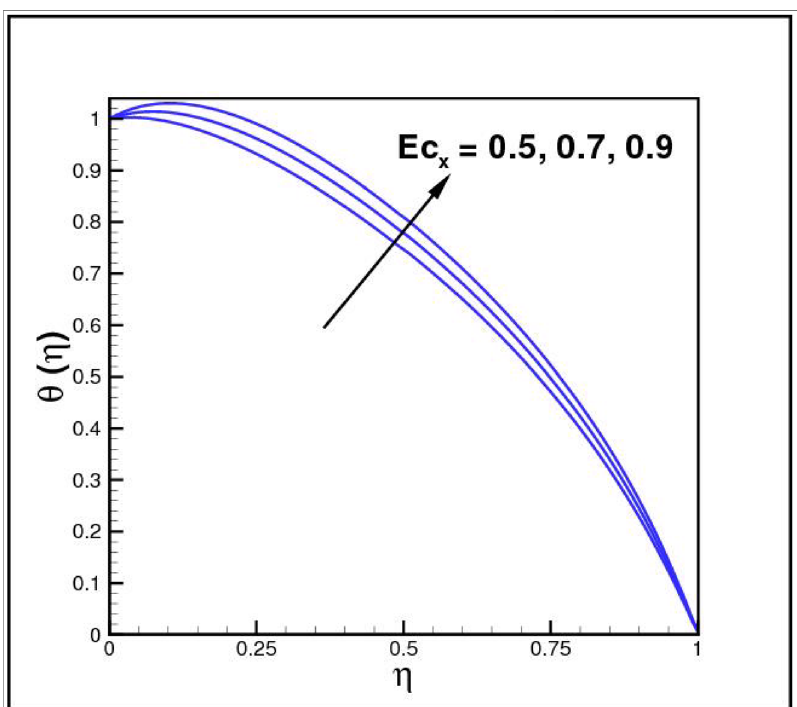
Figure 8. Impact of Ec x on θ ( η